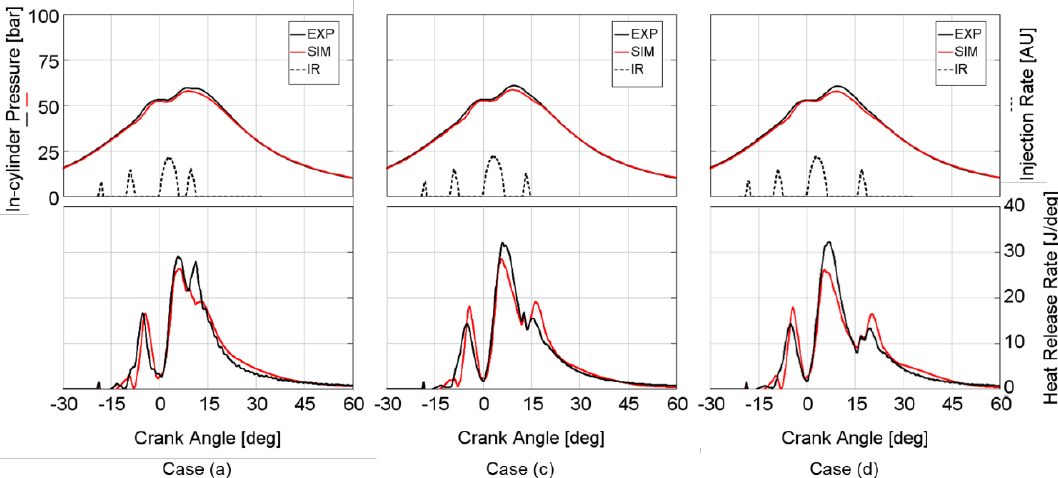
Figure 15. E ff ect of post injection DT–Top: simulated (red) vs. experimental (black) in-cylinder pressure, Figure 15. Effect of post injection DT – Top: simulated (red) vs experimental (black) in-cylinder injection rate (dashed black). Bottom: simulated (red) vs. experimental (black) Heat Release Rate. WP: pressure, injection rate (dashed black). Bottom: simulated (red) vs experimental (black) Heat Release 1500 rpm × 5.0 bar BMEP–Case (a), (c) and Rate. WP: 1500 rpm × 5.0 bar BMEP – Case a), c) and d).